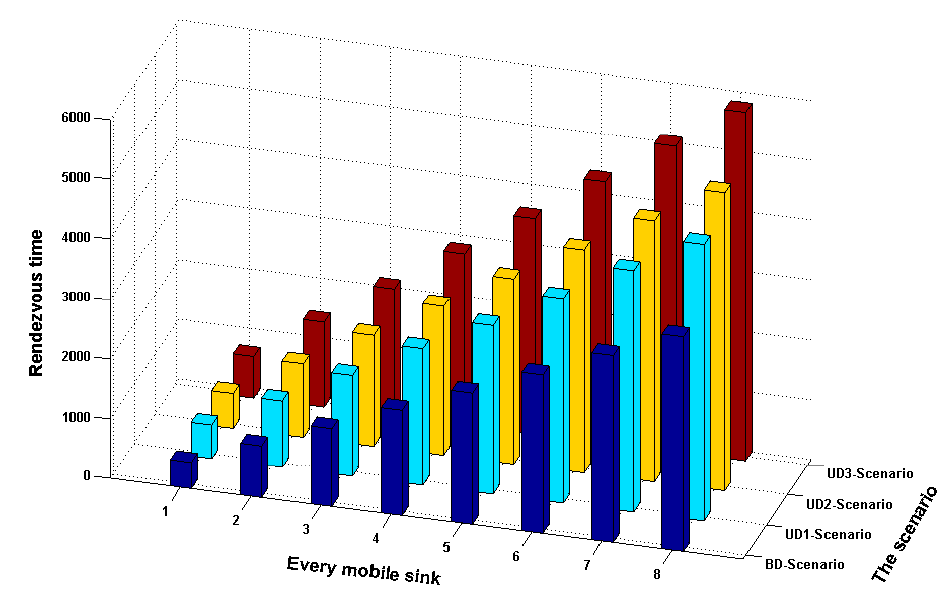
Figure 4. Comparison of the four scenarios in terms of rendezvous time.